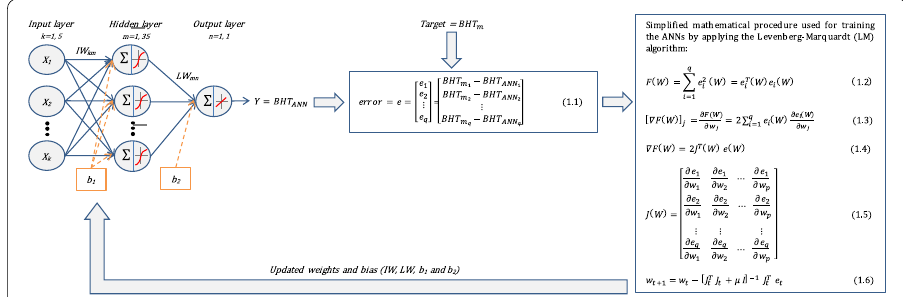
Fig. 2 Schematic diagram showing the conceptual model of a multilayer perceptron with three‑layers, and a summary of the fundamental equations used by applying the Levenberg–Marquardt algorithm: Eq. (1.1) error vector; Eq. (1.2) cost function, where W is the vector of all the weights and biases and q is the total number of samples or patters; Eq. (1.3) where j is the j th element of the gradient; Eq. (1.4) the gradient in matrix form; Eq. (1.5) Jacobian matrix, where p is the total number of neurons; Eq. (1.6) iterative update of weights using the LM algorithm, where w t is the next weight, w t is the current weight, μ is the learning rate factor, and I is the + 1 identity